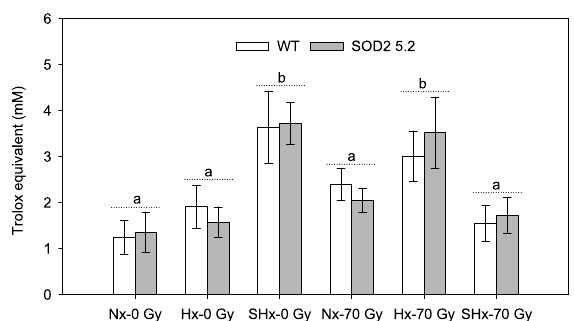
Figure 1. Total antioxidant capacity measured in Trolox equivalents of irradiated (70 Gy) and non-irradiated (0 Gy) WT and SOD2 5.2 males under normoxia (Nx), hypoxia (Hx), and severe hypoxia (SHx) atmospheric conditions. Bars represent means with standard errors of Trolox equivalents measured in samples with four non-irradiated and irradiated males treated or not with low-oxygen atmospheres. Bars followed by different letters are significantly different from each other (LS-means contrasts, P < 0.05), there was no difference between the two lines within any treatment. Figure was created using Sigma Plot (SigmaPlot for Windows version